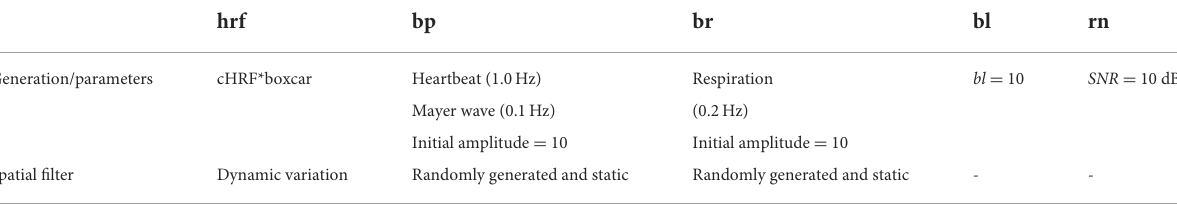
Spatial filter Dynamic variation Randomly generated and static Randomly generated and static -